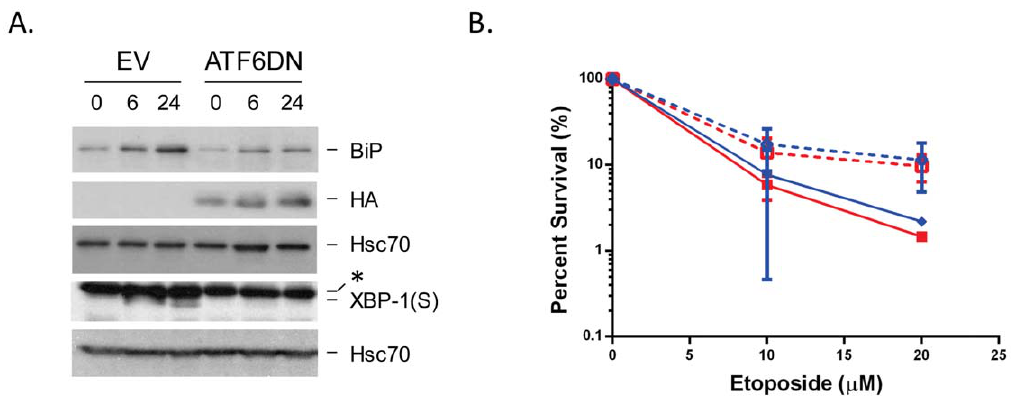
Figure 7. ATF6 does not appear to contribute significantly to altered etoposide sensitivity. A. 293T cells were transfected with empty vector or a dominant negative form of ATF6. 24 hrs later they were treated with thapsigargin for 6 and 24 hrs and cell lysates were prepared, separated on SDS gels, transferred and blotted for the indicated proteins. The asterisk represents a non-specific band recognized by the anti-XBP-1 antiserum. B. Wild-type MEFs were co- transfected with GFP and either an empty vector (blue) or a dominant negative form of ATF6 (red) as described in the Materials and Methods section. GFP-positive cells were isolated and either left untreated (solid lines) or pre-treated with thapsigargin for 6 hrs (dotted lines) before incubating with the indicated concentrations of etoposide. Clonal survival assays were performed as in Figure